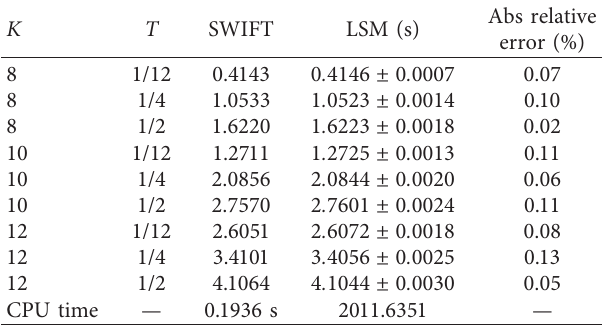
Table 2: Comparisons of the CPU time and accuracy for of SWIFT and LS